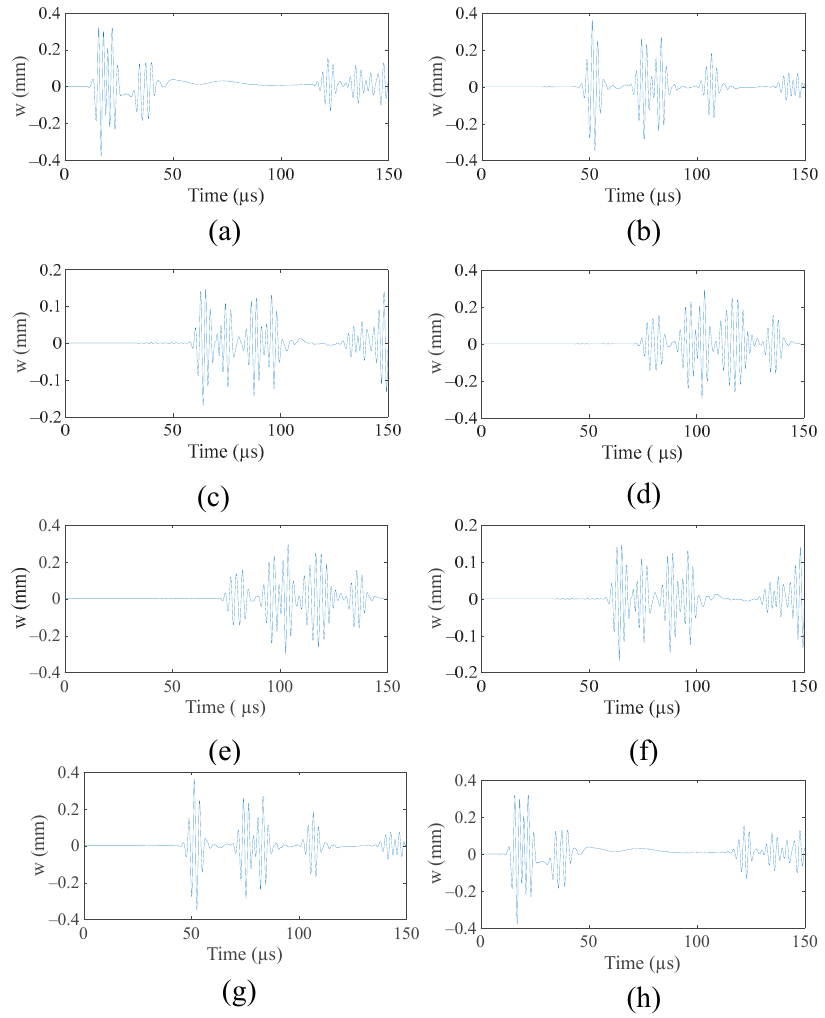
Figure 9. The initial time domain signals received by the eight receivers after one actuating in the center of area three. ( a ). The signal received by the receiving point (140, 175). ( b ). The signal received by the receiving point (40, 175). ( c ). The signal received by the receiving point (5, 140). ( d ). The signal received by the receiving point (5, 40). ( e ). The signal received by the receiving point (40, 5). ( f ). The signal received by the receiving point (140, 5). ( g ). The signal received by the receiving point (175, 40). ( h ). The signal received by the receiving point (175, 140).